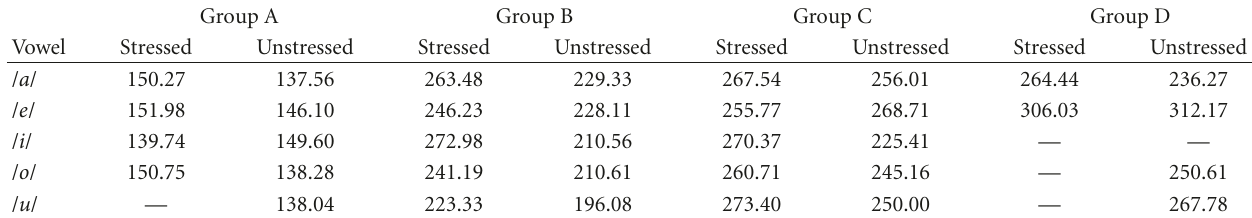
Table 10: Mean ( μ ) values of pitch in the impaired corpus for mispronounced vowels.